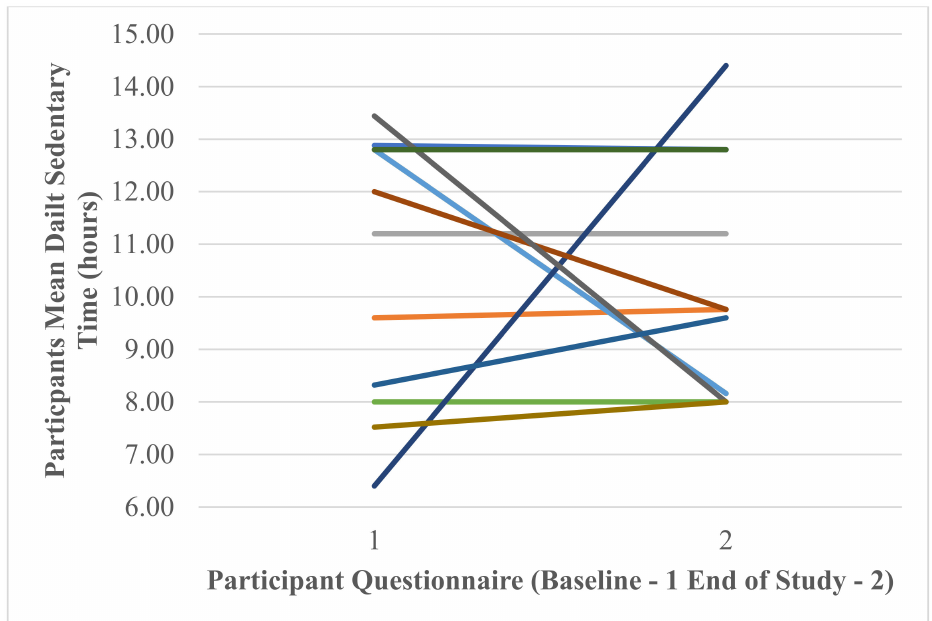
Figure 13. Individual participants’ self-reported mean daily hours of sedentary time at baseline and end of study (each coloured line represents one of the 12